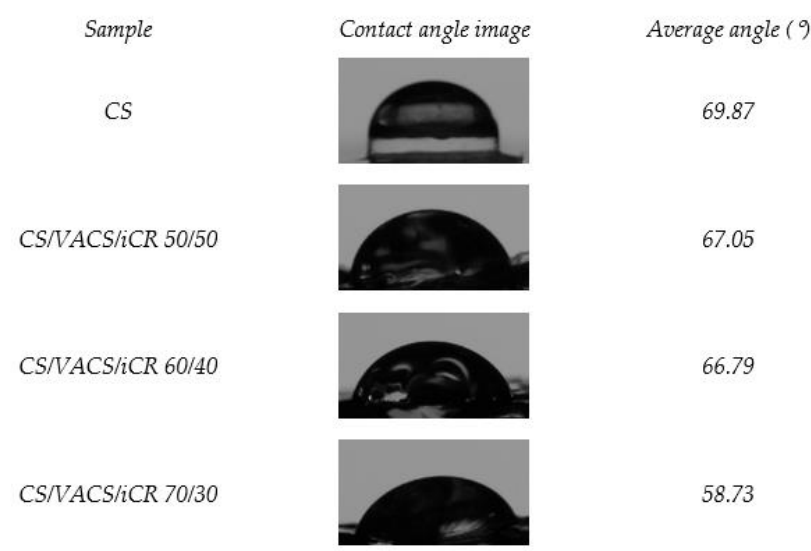
Figure 6. Contact angle images and their values of the CS/VACS/iCR 50/50, 60/40, and 70/30.